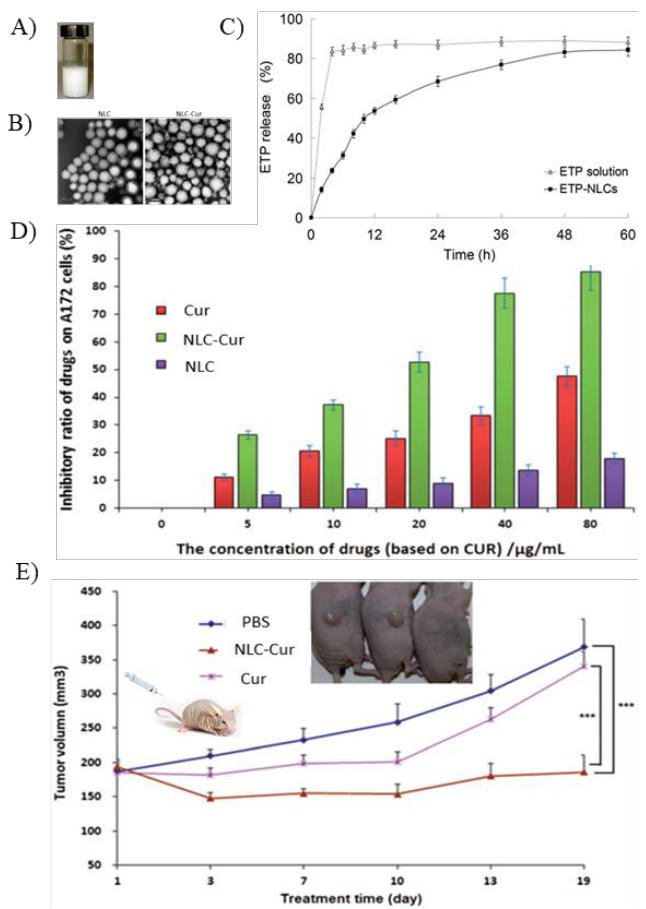
Figure 5. In vitro and in vivo characterization of drug-loaded NLCs. ( A ) Drug-free NLCs formulation; ( B ) TEM images showing the spherical nanosize of NLCs and Cur-NLC; ( C ) in vitro release study showing controlled release of ETP from ETP-loaded NLCs; ( D ) inhibitory effect of Cur and Cur-NLC on A172 cells (human glioblastoma); and ( E ) Tumor inhibition effect of Cur, Cur-NLC and phosphate buffer saline (PBS) on nude mice bearing A172 (human glioblastoma) [19,71]. Adapted with permission from Taylor and Francis.